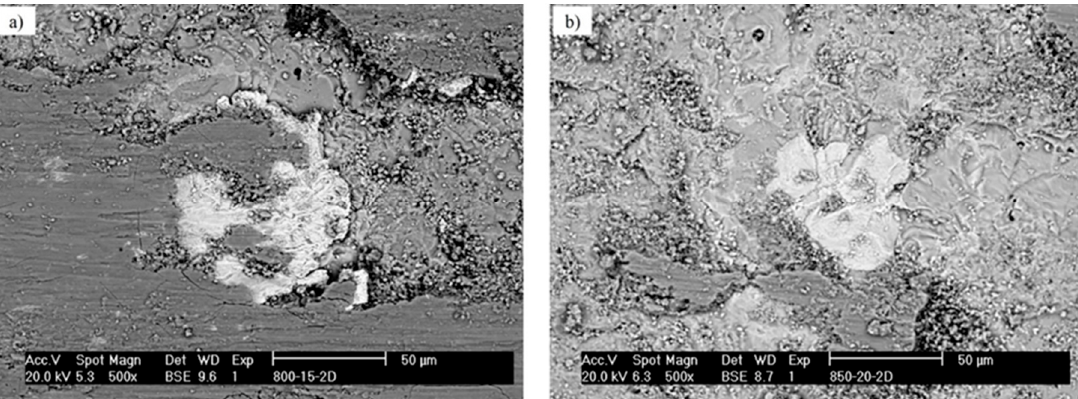
Figure 14. SEM images of specimens of AISI 304L stainless steel after pin-on-disk wear testing: ( a ) coated with α -Al 9 FeMnSi (processed at 850 °C and 20 MPa) and, ( b ) untreated.